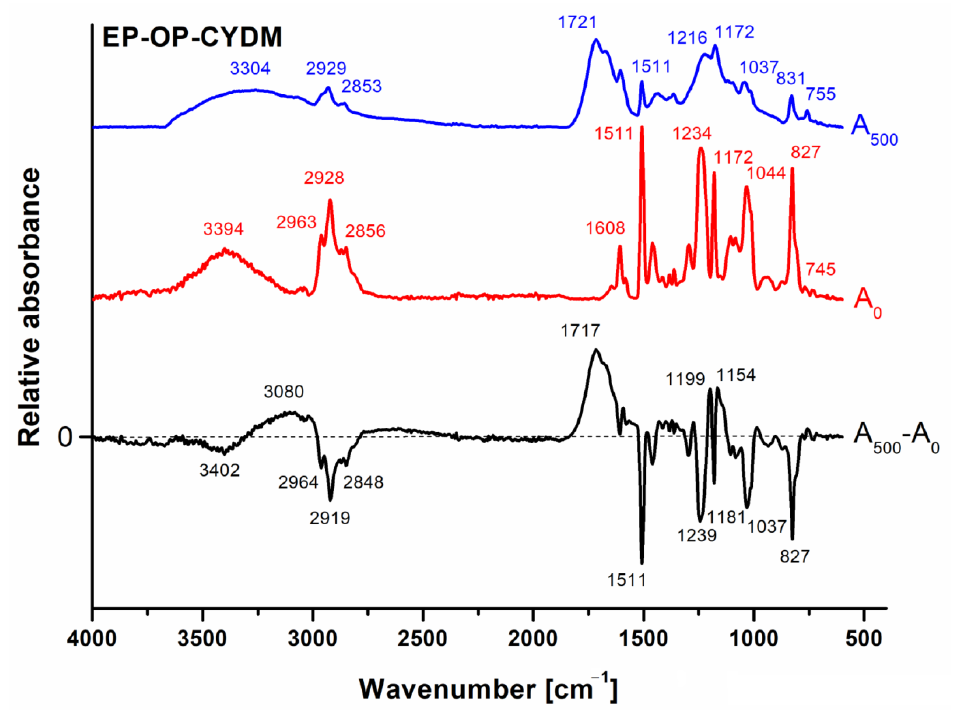
Figure 7. FT-IR spectra of the S–IPN EP–OP–CYDM recorded before (A 0 ) and after 500 h exposure (A 500 ) and the difference spectrum (A 500 –A 0 ).